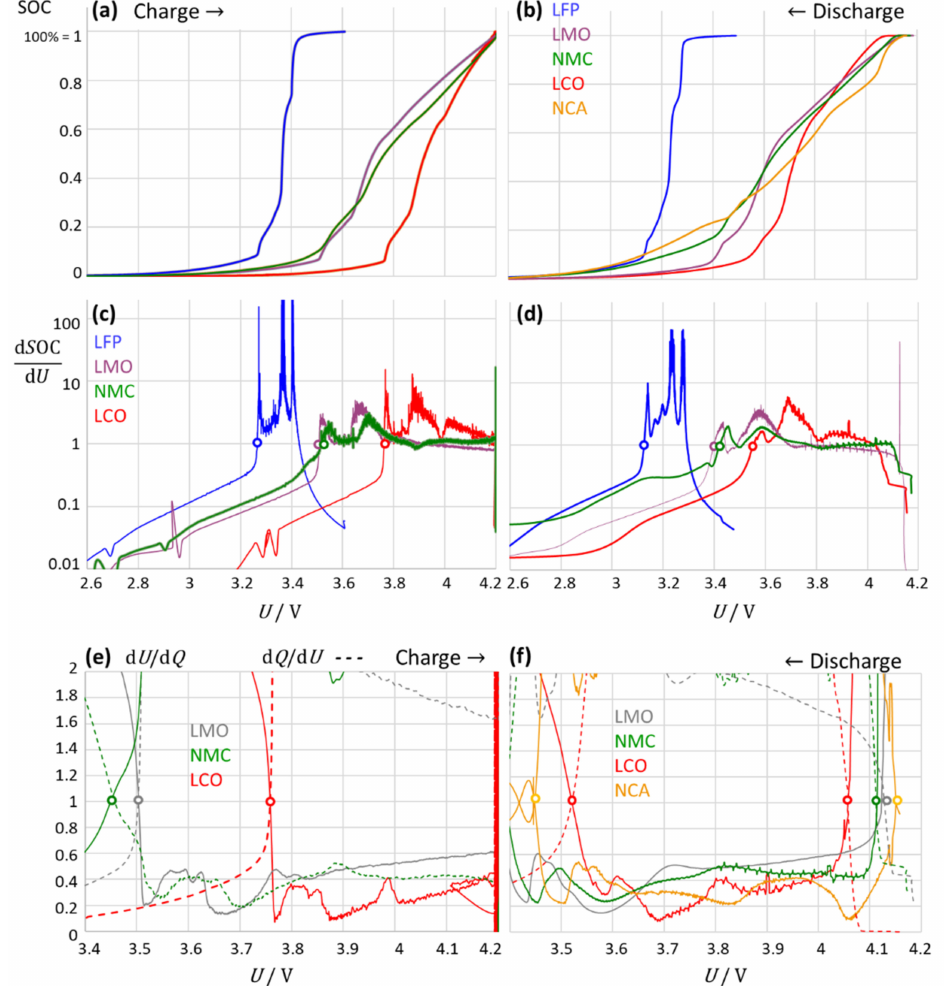
Figure 7. Test of the method with highly noisy data. Complete charge –discharge curves of different lithium-ion cell chemistries. ( a , b ) State-of-charge (SOC = Q / Q 0 ) versus cell voltage U . ( c ) Differential capacity d S OC/d U as measured without smoothing. ( d ) Differential capacity d S OC/d U with smoothing by moving average over 13 data points. ( e ) Intersection method for the charge curves: differential capacity d Q /d U (“IC”, dashed), incremental voltage (“DV”, solid). ( f ) Intersection method for the discharge